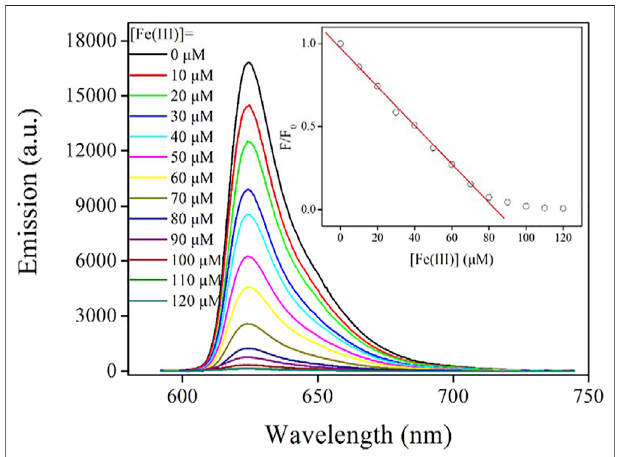
FIGURE 8 | Emission spectra of the AuNCs diluted by pure water (v:v (cid:1) 1:10), upon increasing Fe(III) concentration from 0 to 120 μ M. Inset: Stern – Volmer equation fi tted with Formula 4